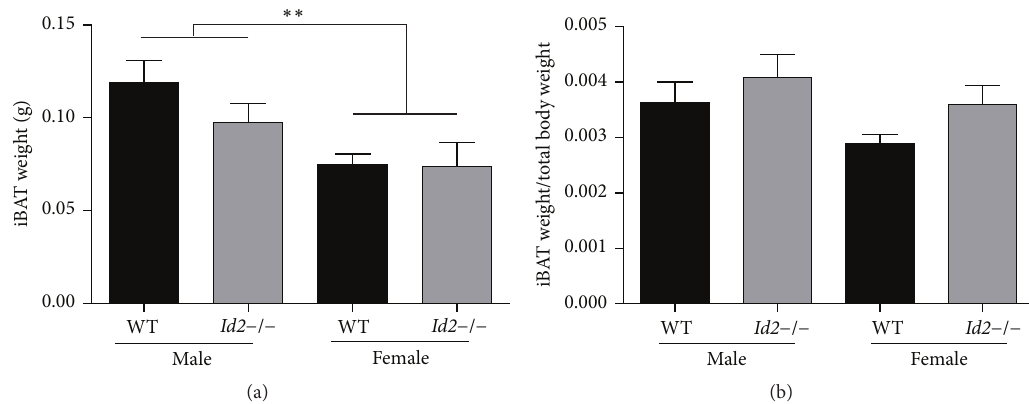
Figure 2: Brown Adipose tissue weight in Id2 − / − mice. (a) Interscapular brown adipose tissue (iBAT) mass (g) from WT and Id2 − / − mice. (b) Ratio of weight of iBAT tissue to total body mass from WT and Id2 − / − mice. Values are mean ± SEM. Two-factor ANOVAs were performed followed by Tukey’s post hoc tests, ∗∗ 𝑝 < 0.01 . No significant differences were observed between groups in the iBAT mass/body mass